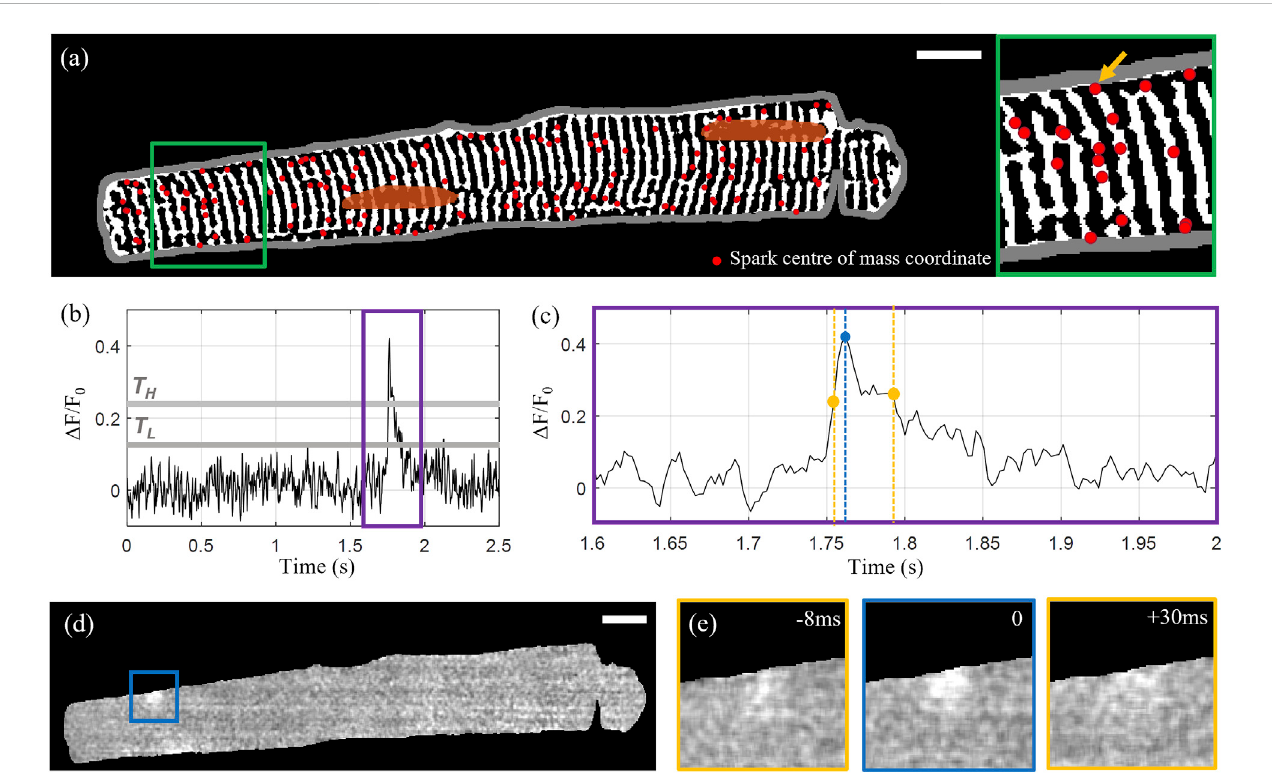
FIGURE 2 Calciumsparkdetectionandcorrelationwithcellstructure. (A) Centreofmasscoordinates(redmarkers)foratotalof139detectedsparksoverlaidonthe extracted tubular microstructure of the example Cell X. The cell membrane outline isshown ingrey and the manually segmented nuclei are shown in orange. (B) Intensity time pro fi le through the 1,000-frame sequence for the spark indicated by the yellow arrow in the inset shown on the right side of (A) . The upper andlowerintensitythresholdsareindicatedby T H and T L respectively(greylines). (C) Azoom-inofthetimeregionindicatedbythepurplerectanglein (B) . The detected peak is indicated by the blue marker, and the fi rst and last frames above F50 are indicated with yellow. (D) Normalized fl uorescence intensity at thetime pointcorresponding totheselectedspark ’ speakintensity. (E) The 100by100pixelregion centred onthesparkcentroidindicatedbythebluesquare in panel (D) at peak intensity (middle) with the intensity distributions at the timepoints corresponding to F50 before and after the peak shown on the left and right respectively. Scalebar: 10 μ